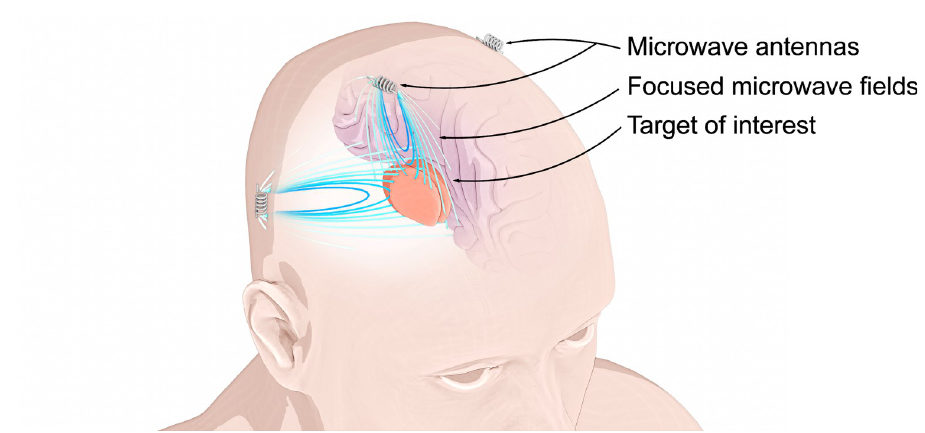
Fig 1. Illustration of non-invasive MW focusing based on magnetic inference with small coil (magnetic dipole) antennas placed near the surface of the head.